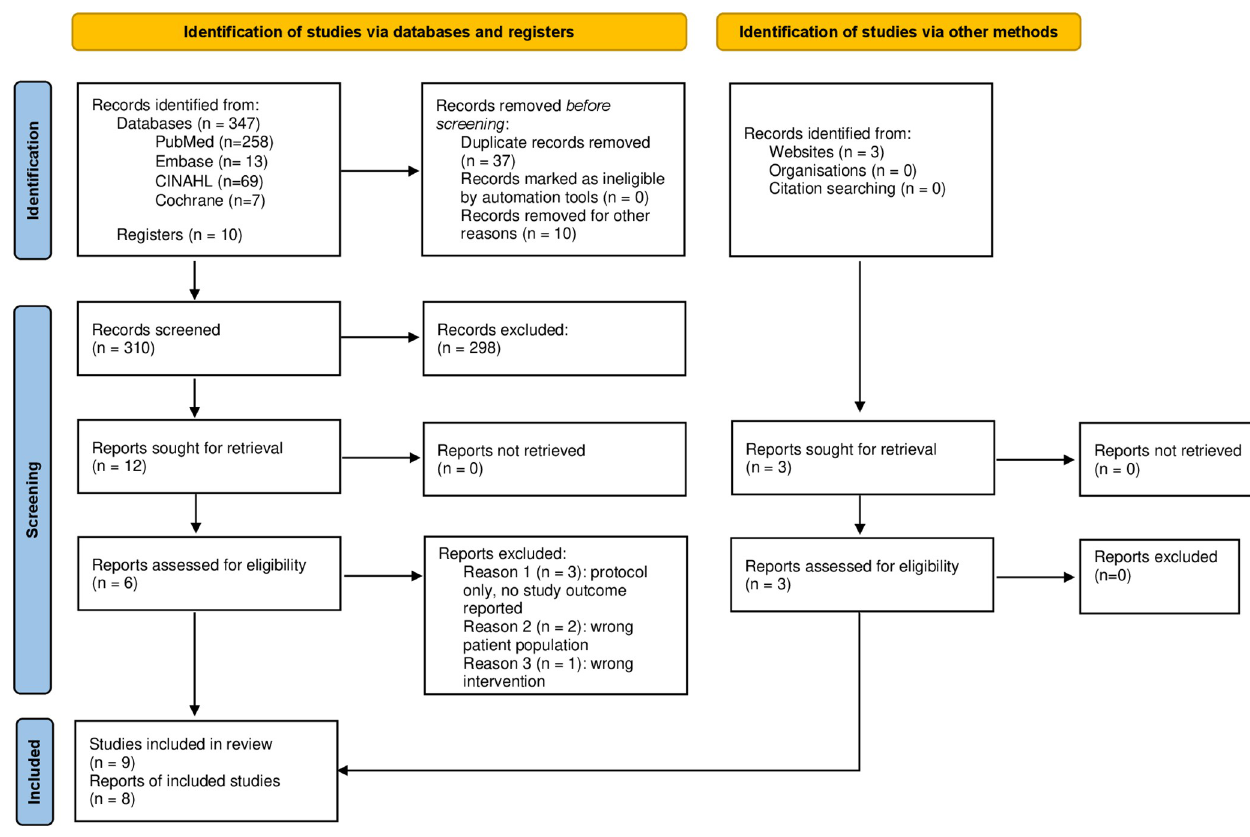
Fig 1. PRISMA flow